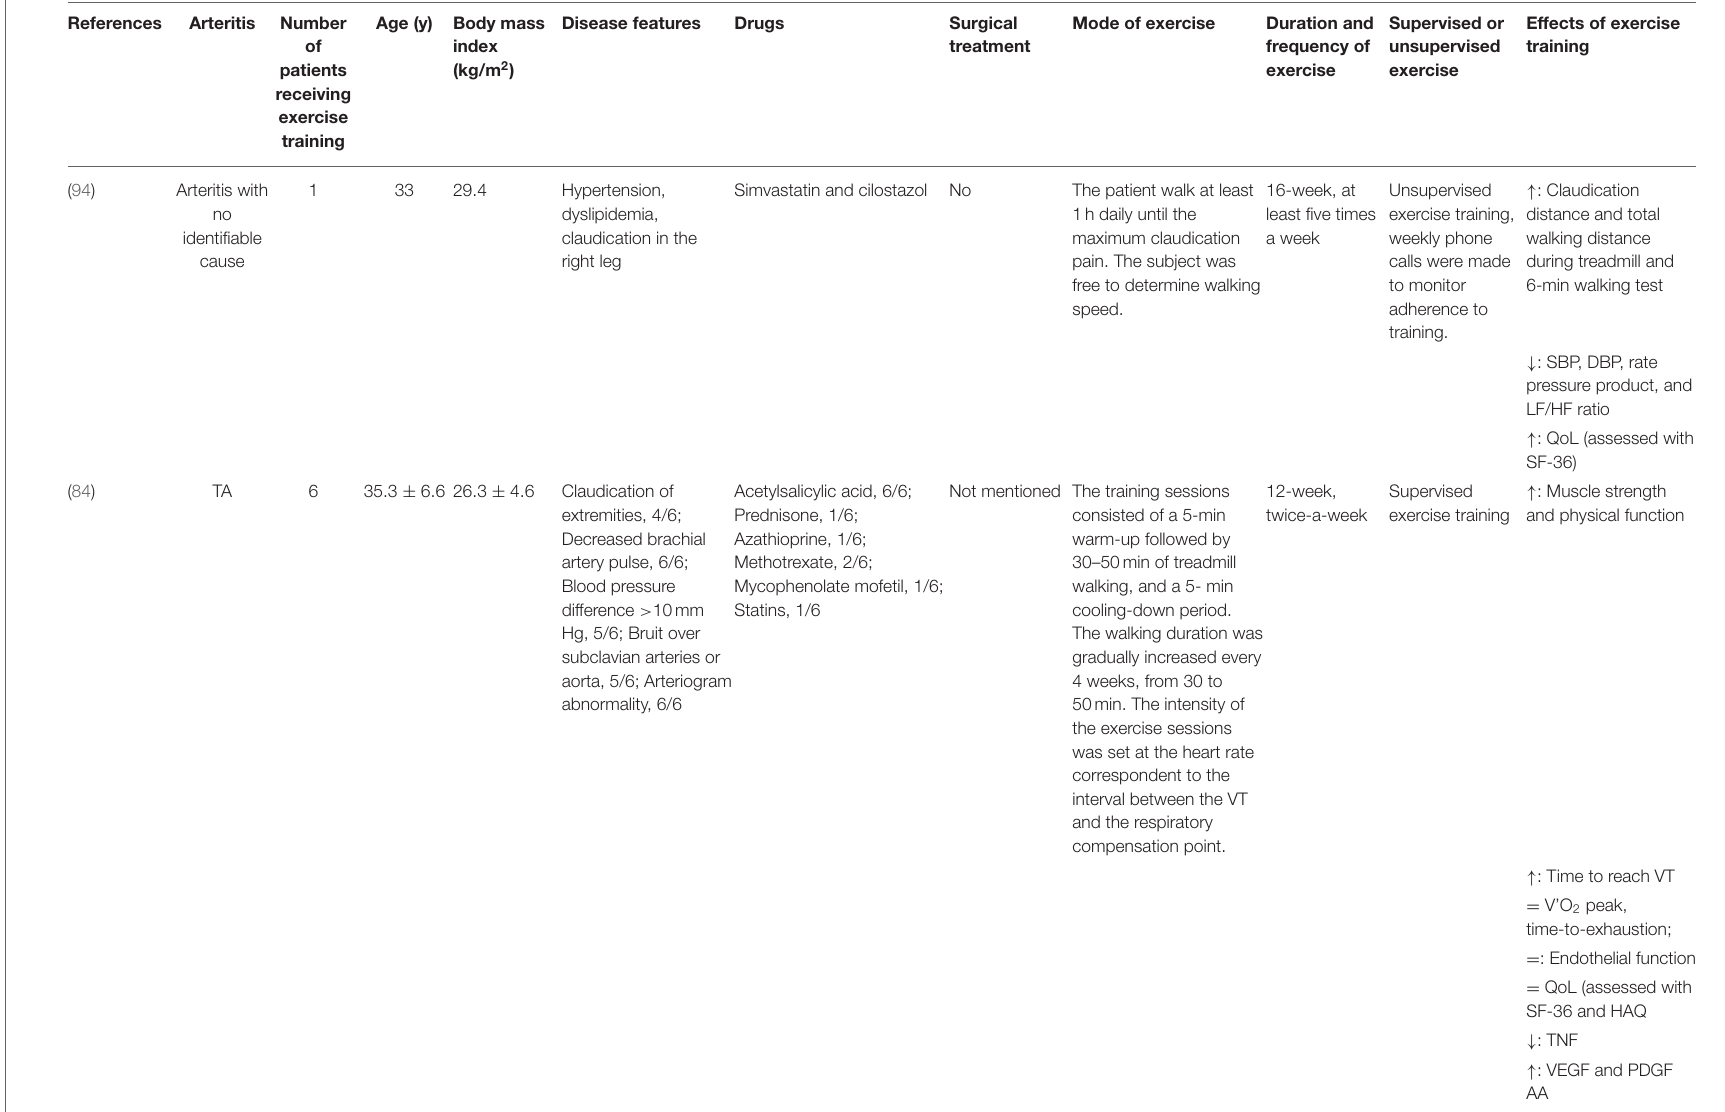
TABLE 2 | Summary of studies about exercise training on patients with